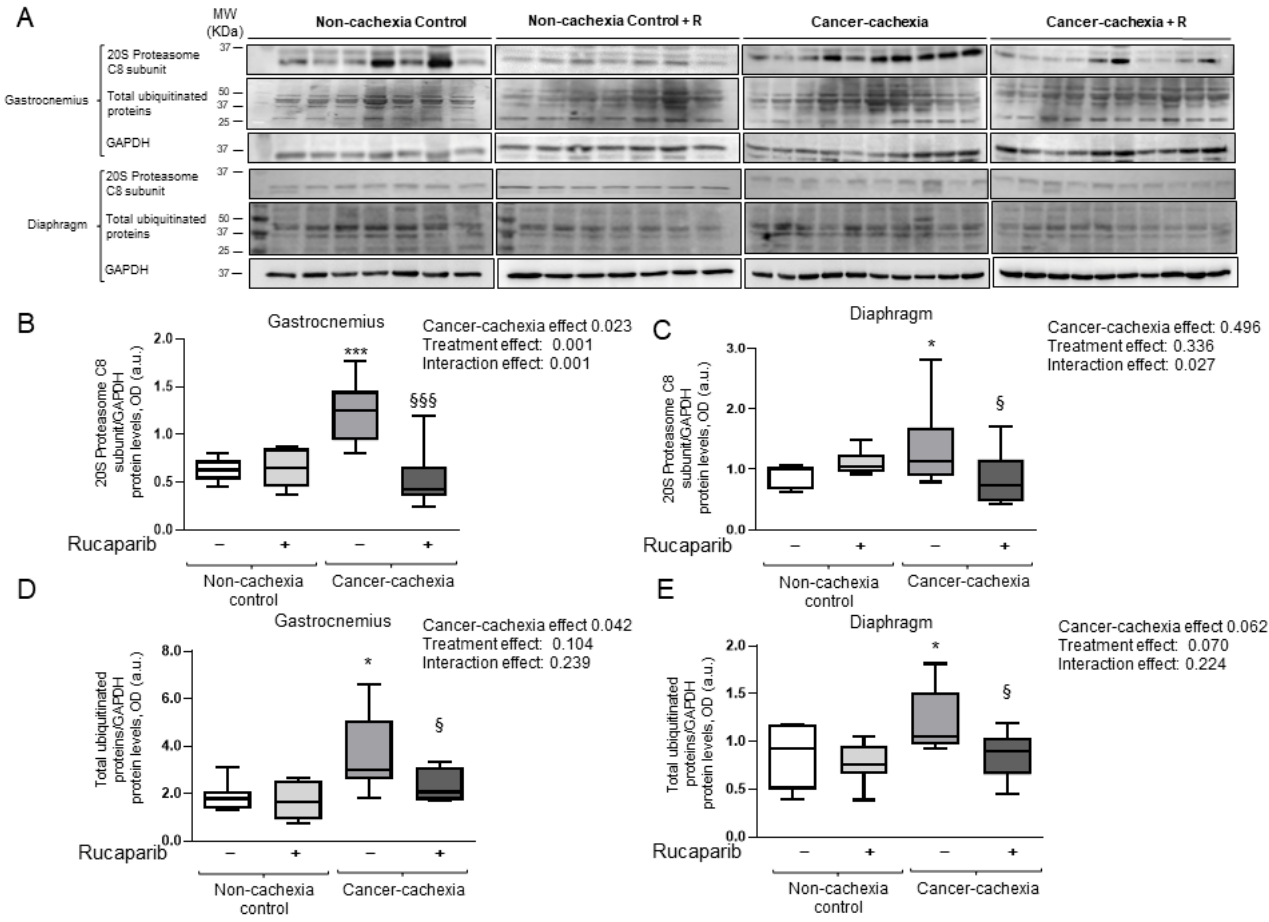
Figure 7. Immunoblot examples of 20S proteasome C8 subunit, total ubiquitinated proteins, and GAPDH proteins in the gastrocnemius and diaphragm muscles of all experimental groups of mice ( A ). Box plot representation of 20S proteasome C8 subunit protein levels in the gastrocnemius ( B ) and diaphragm ( C ) muscles of the different study groups of mice. Box plot representation of total ubiquitinated protein levels in the gastrocnemius ( D ) and diaphragm ( E ) muscles of the different study groups of mice. Abbreviations: GAPDH, glyceraldehyde-3-phosphate dehydrogenase; MW, molecular weight; kDa, kilodalton; OD, optical densities; a.u., arbitrary units; − , untreated with rucaparib; +, treated with rucaparib. Statistical significance: * p ≤ 0.05 and *** p ≤ 0.001 between the untreated non-cachexia controls and the non-treated cancer cachexia mice; § p ≤ 0.05 and §§§ p ≤ 0.001 between the cancer cachexia mice treated with rucaparib and the non-treated cancer cachexia mice. Two-way ANOVA significance ( p value) of cancer cachexia and treatment and interaction effects are also shown for each variable. Uncropped WB images were shown in Figure